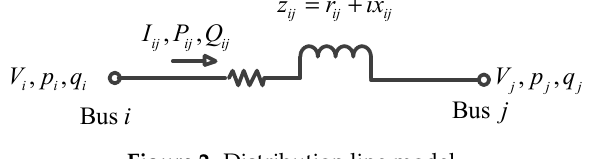
Figure 2. Distribution line model.